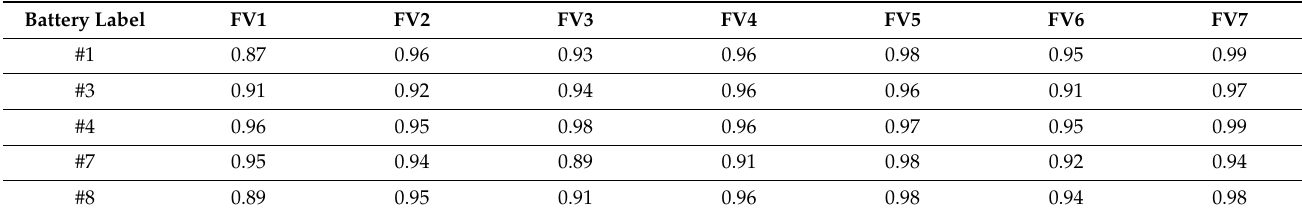
Table 2. Pearson correlation coefficients between feature variables and